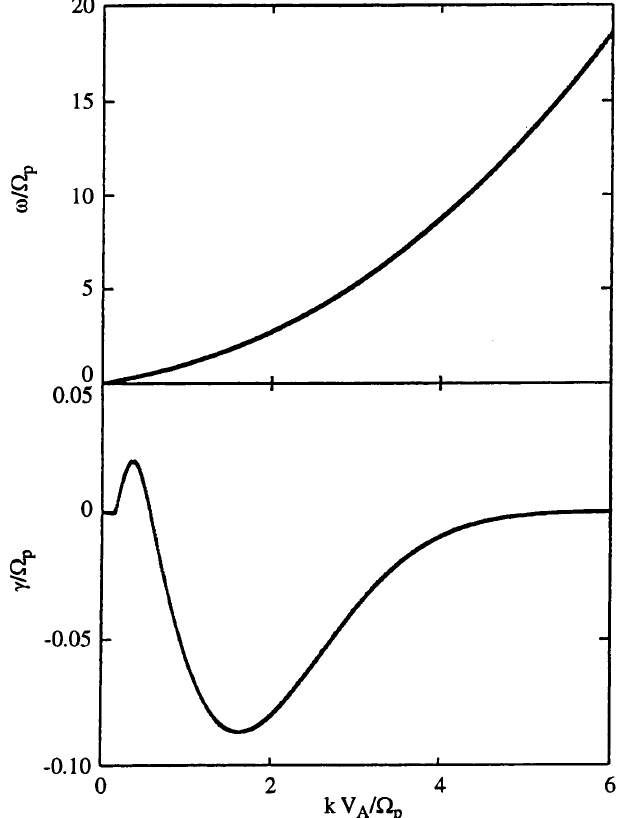
Fig. 5. Parallel propagating unstable mode by L - R coupling forced by an open nongyrotropy of alpha particles embedded in a gyrotropic electron-proton plasma (Motschmann and